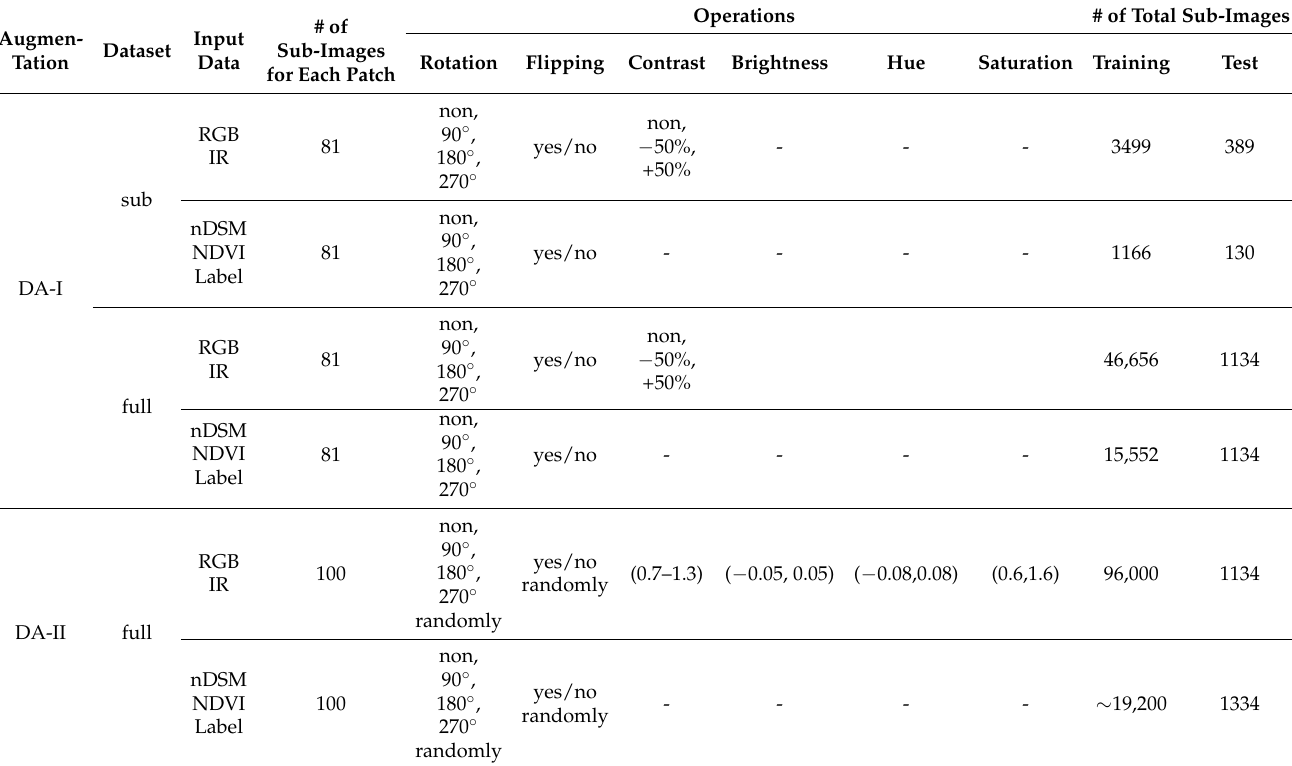
Figure 2. ISPRS Potsdam full-datasets and sub-datasets in UTM WGS84 datum. Table 1. The applied augmentation operations for the Potsdam